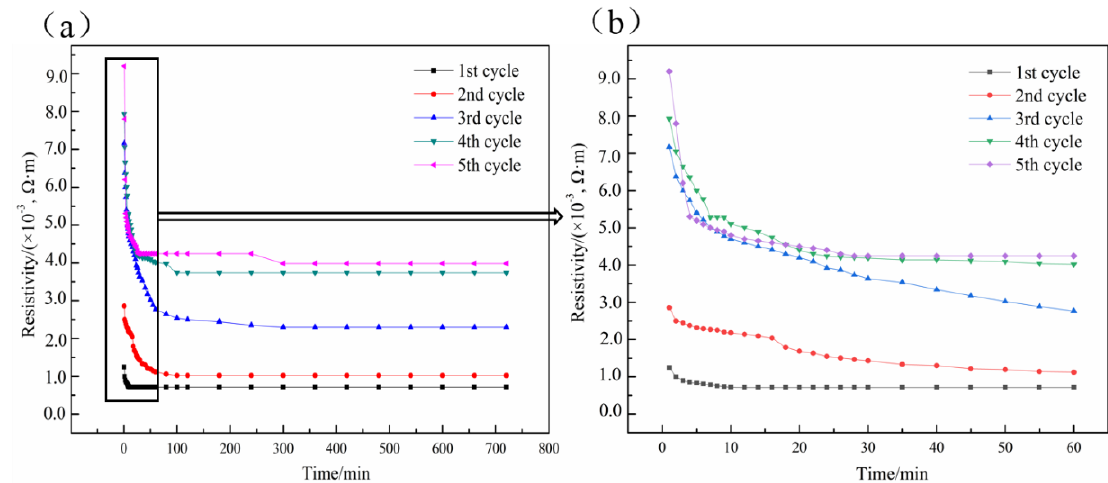
Figure 9. Resistivity–time curves of the coating cyclic electricity test ( a ) and graph of the corresponding heating stage 0-60min ( b ).